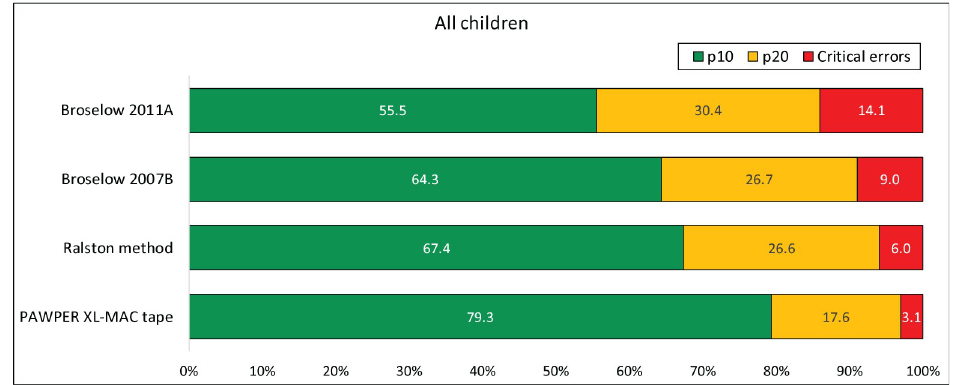
Fig 2. Analyses of the overall accuracy of the weight estimation systems. The chart shows the proportion of weight estimations falling within 10% and 20% of actual weight (p10 and p20 respectively) as well as the proportion of critical weight estimation errors ( > 20% error). The data for the Ralston method was obtained from the published study [9]. The McNemar test was significant at the p < 0.001 level for every comparison of p10 and p20. The PAWPER XL-MAC method’s p10 beached the 10% improvement criterion when compared with the other methods. The p10 of the Broselow 2011A was clinically inferior to all other methods.